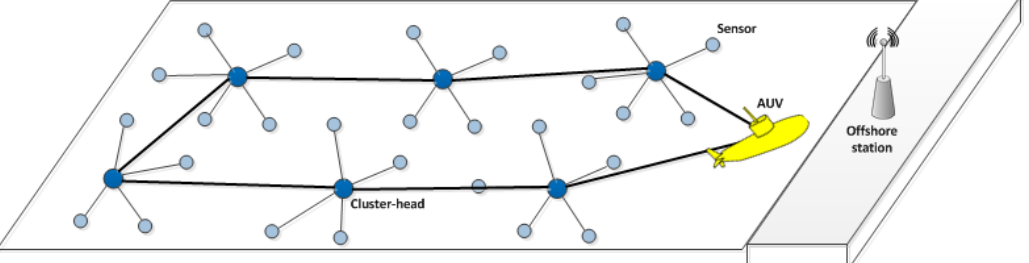
Figure 2. How the autonomous underwater vehicle (AUV) discovers cluster head and assigns different frames for